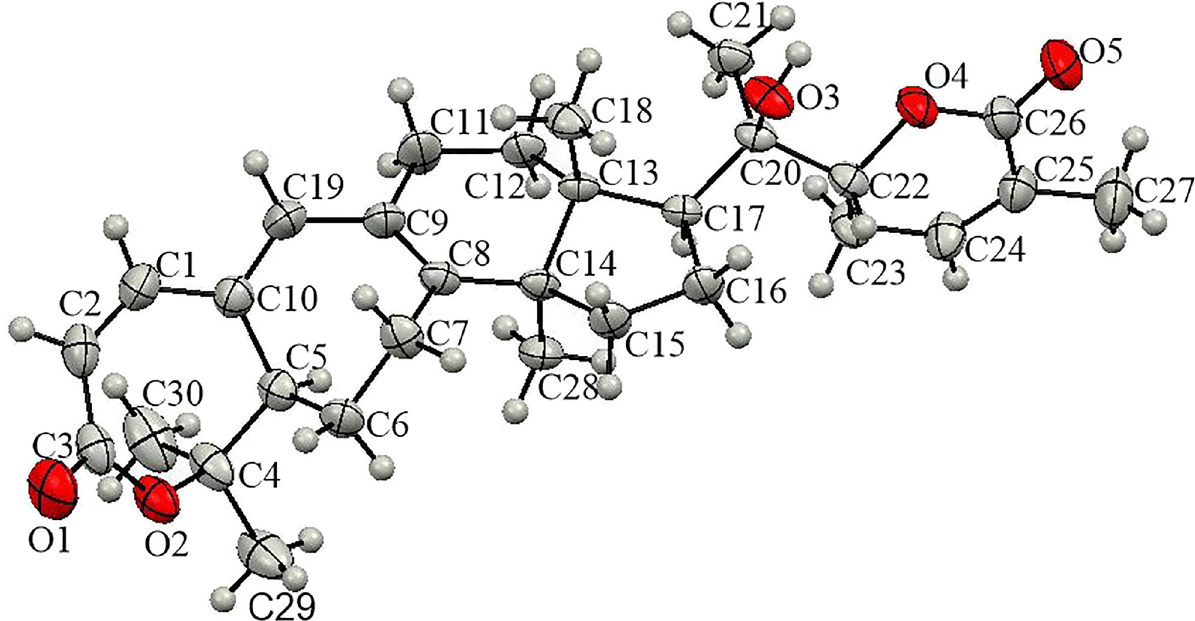
Table  : Data collection and